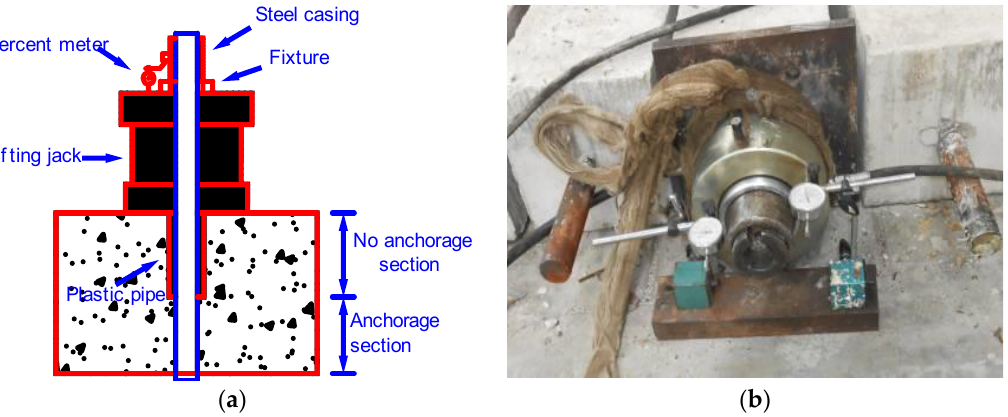
Figure 2. Hydraulic loading system. ( a ) Loading system diagram. ( b ) Specimen loading.